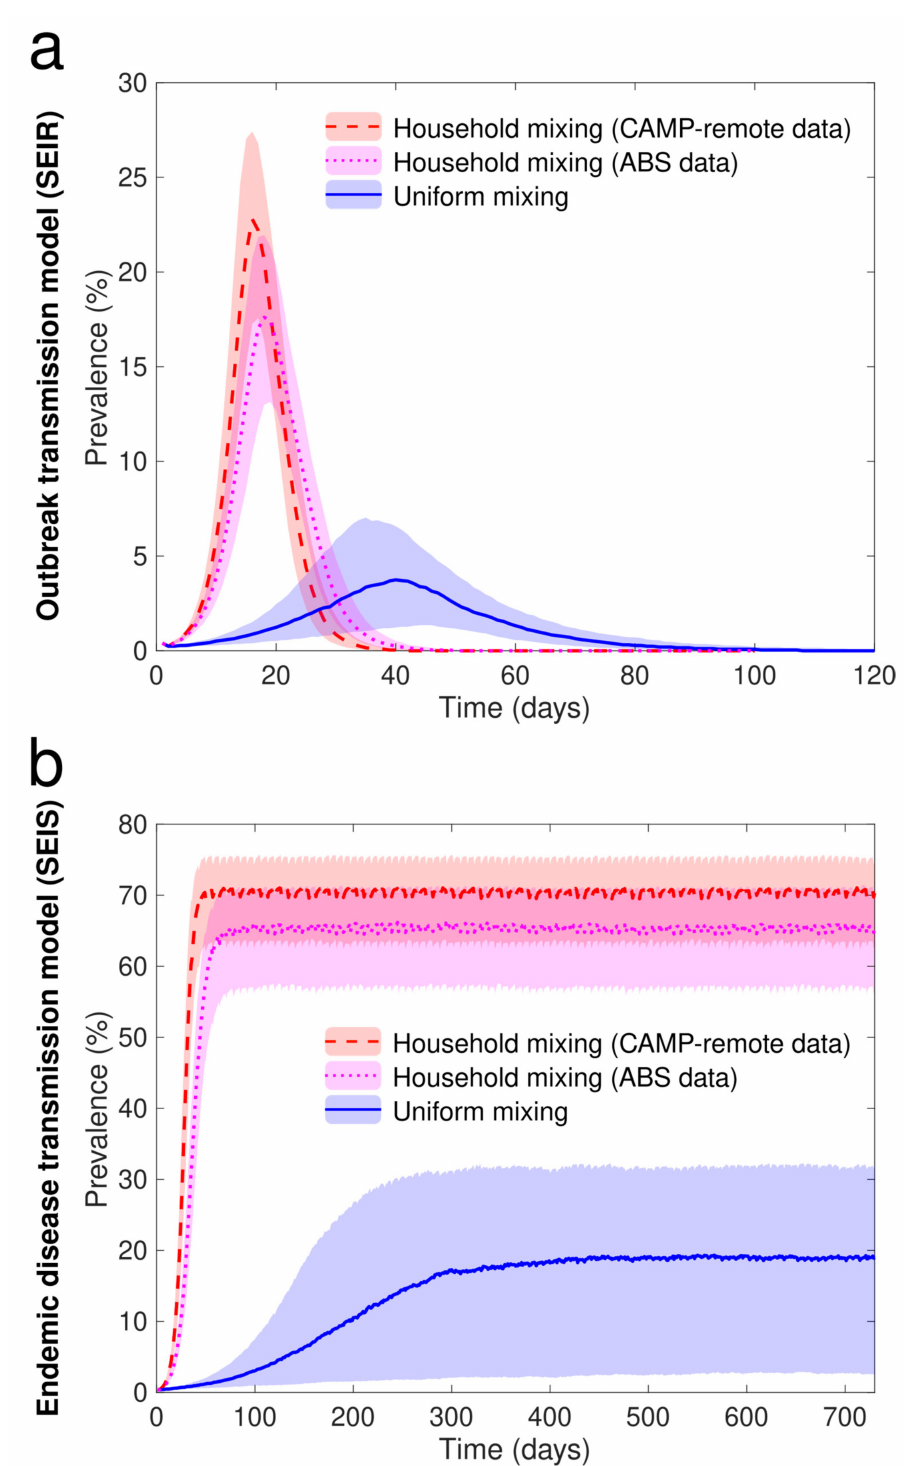
Figure 6. ( a ) The prevalence of infection arising from simulations of an influenza-like SEIR model under different mixing assumptions. ( b ) The prevalence of infection arising from simulations of an en- demic disease in an SEIS model under different mixing assumptions. Both models are parameterized to reflect the study